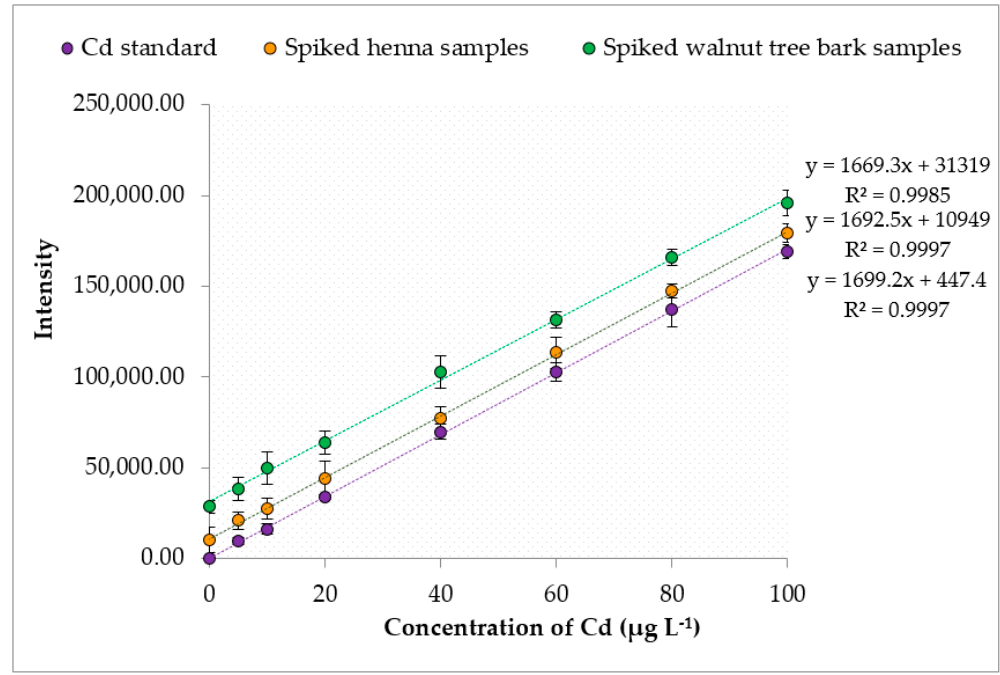
Figure 2. Recoveries of Cd from spiked henna and walnut tree bark samples.